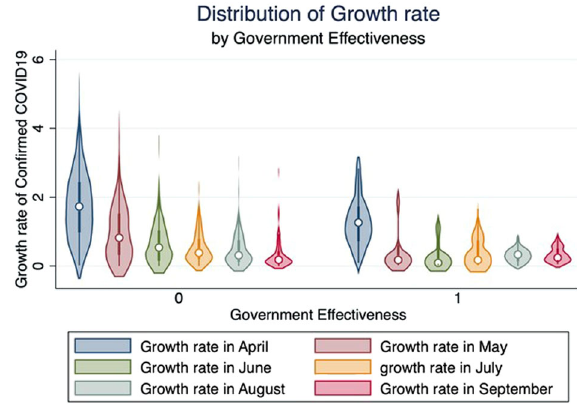
Fig. 2 Distribution of the COVID-19 growth rate by government